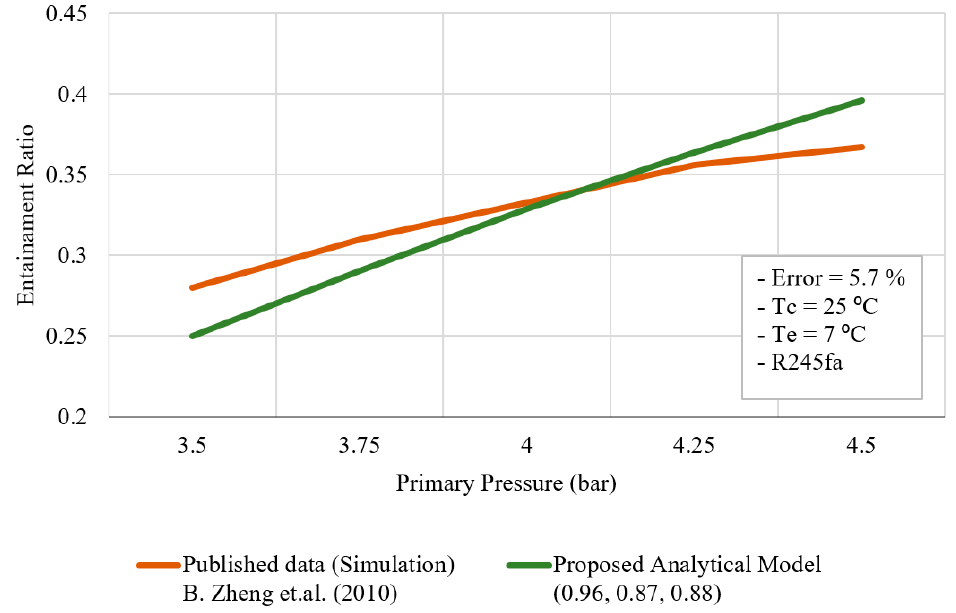
Figure 13. Validation with simulation data from literature .